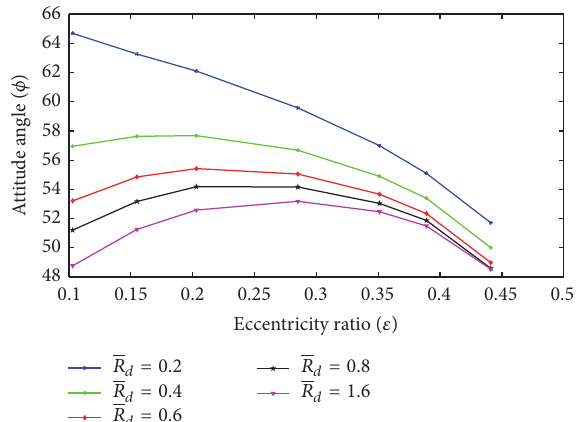
Figure 6: Effect of relief track depth ratio on Sommerfeld